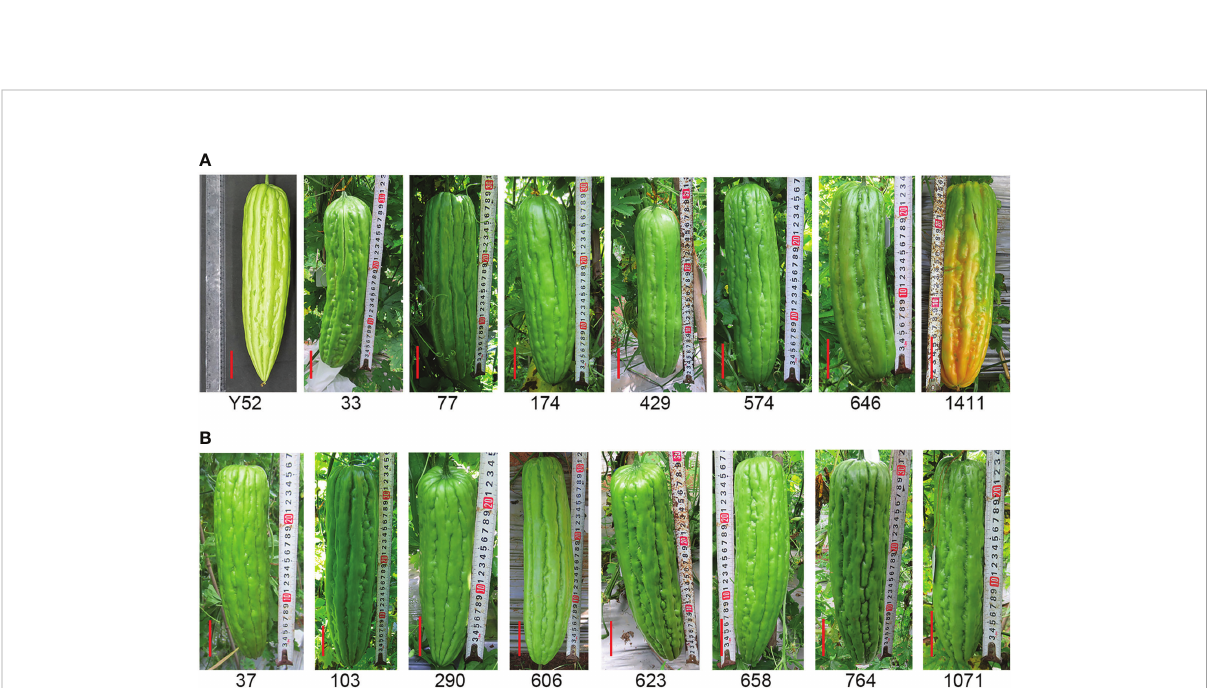
FIGURE 5 Mutation for fruit shape. (A) Mutants with nearly round phenotype at the blossom end. (B) Mutants with a truncated phenotype at the base of the fruit compared with Y52. Scale bar in red color = 5